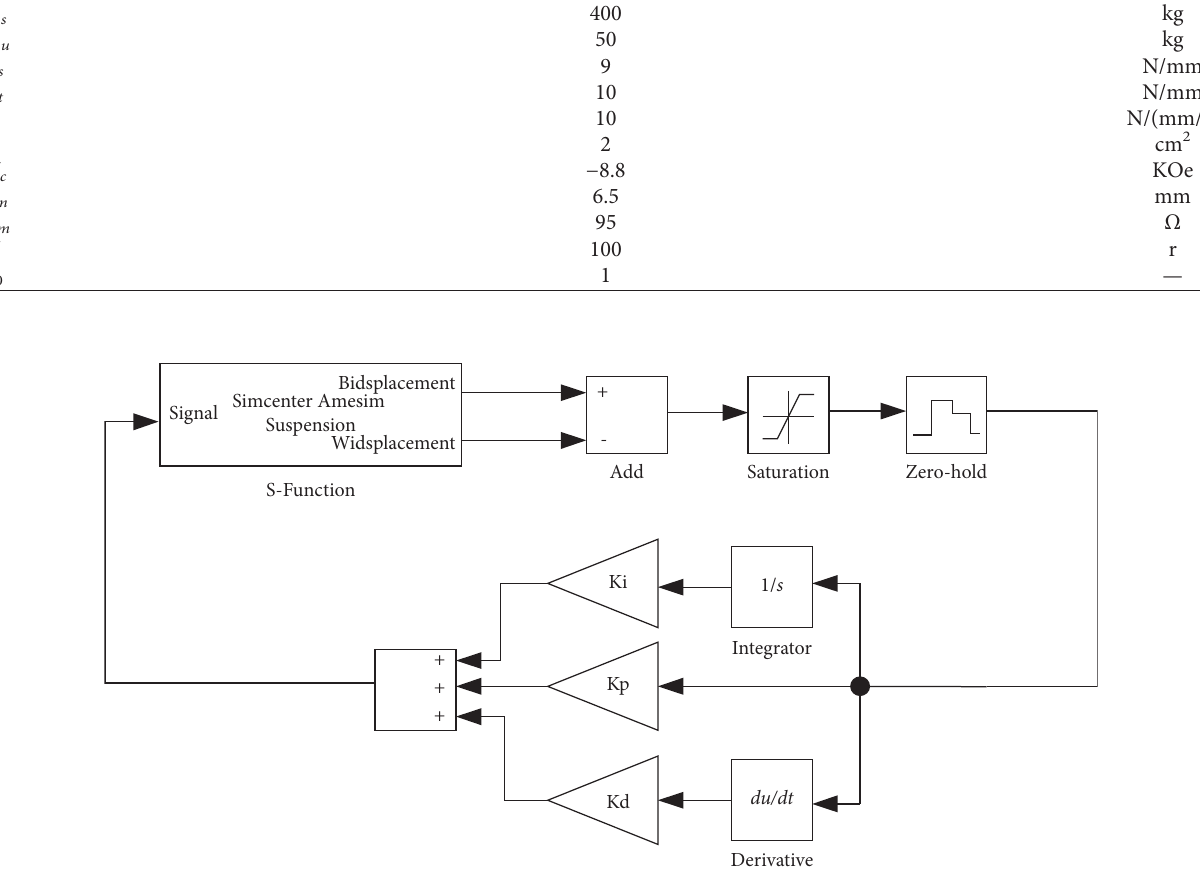
Figure 7: Simulink control